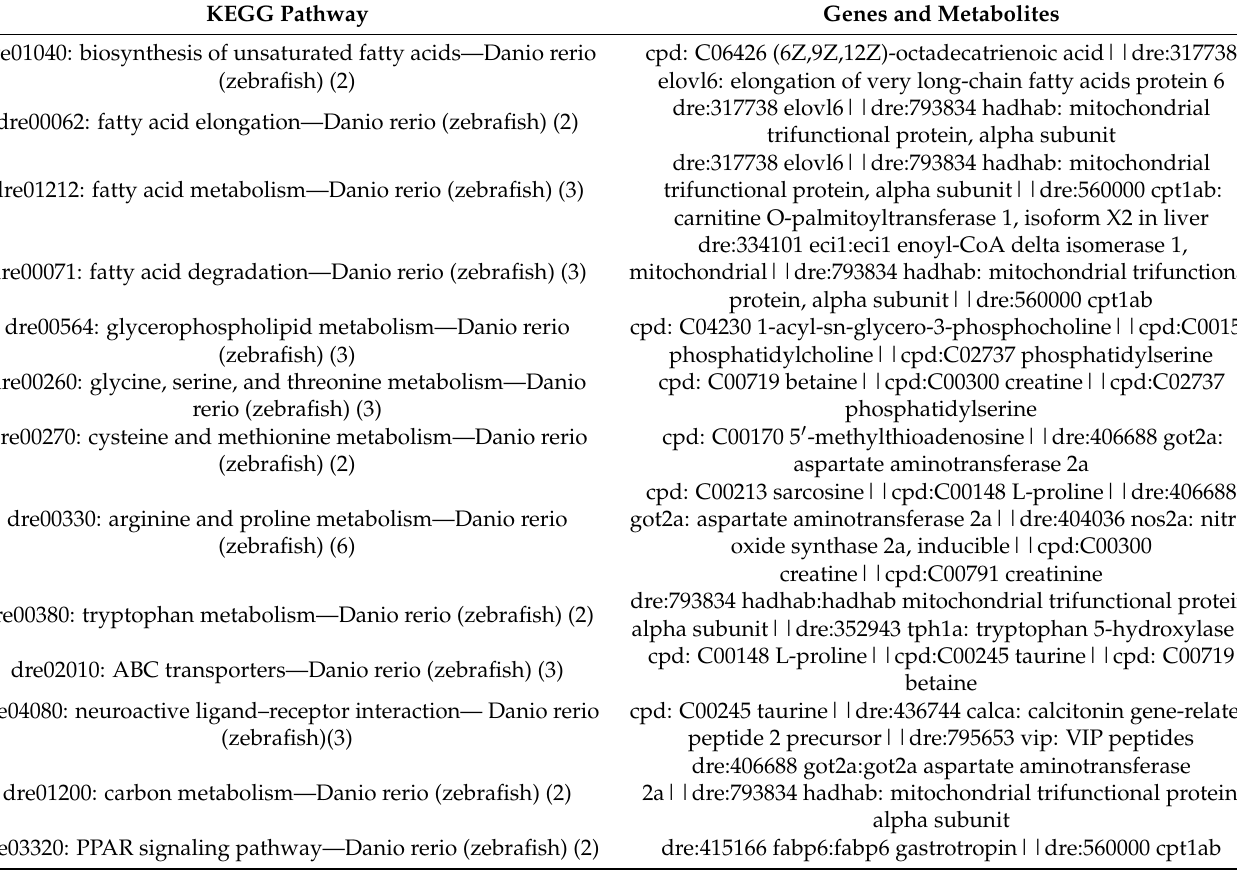
Table 4. Differential genes and metabolites in KEGG-related pathways after cyantraniliprole exposure (padj < 0.05, |log2 (Fold change)| ≥